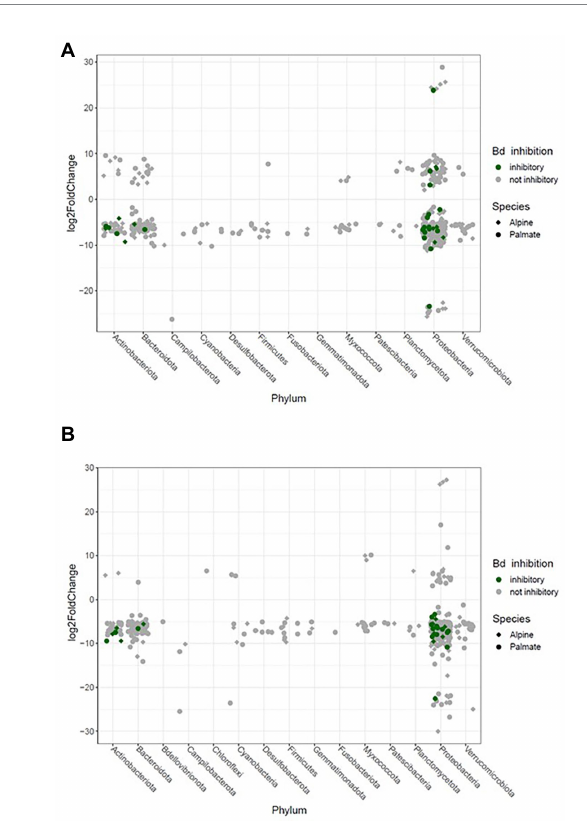
FIGURE 6 Significant log2 fold changes in abundance of bacterial phylotypes in the skin microbiota of newts over their transfer from the wild into captivity on the short term (1 month) (A) and longer term (10 months) (B) . Each phylotype is represented by a point whose position indicates the change in relative abundance throughout the transition, and whose shape characterizes the newt species in which it significantly varies in abundance. The color code indicates potential protective function of these phylotypes against Bd .